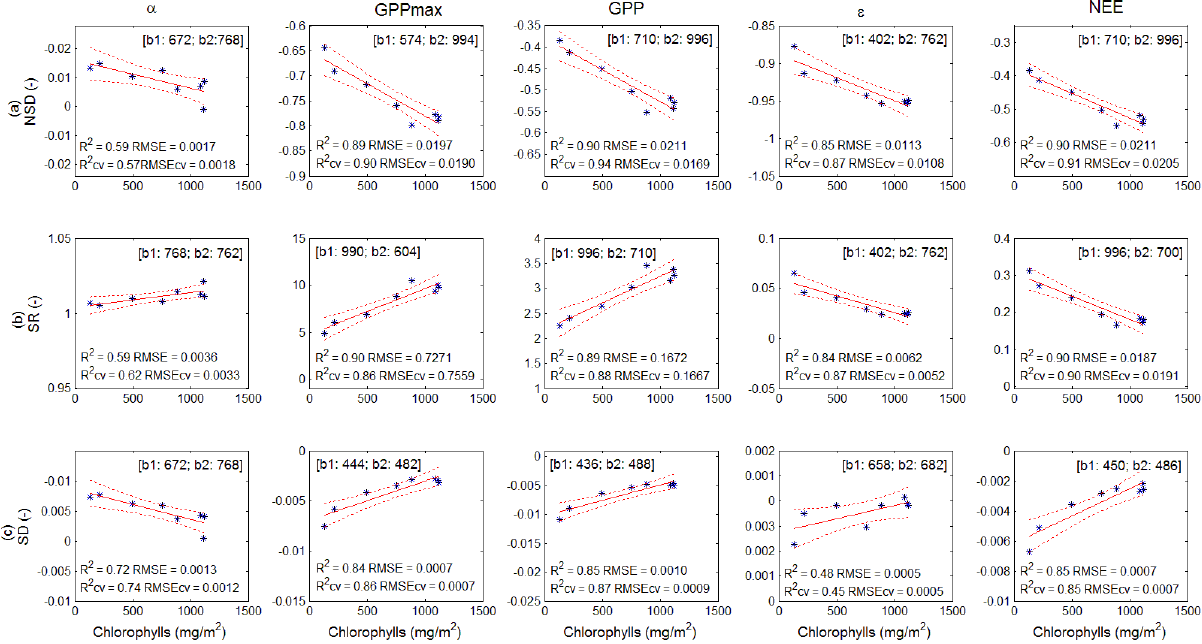
Figure 8. Correlation between selected (a) NSD-, (b) SR- and (c) SD-type indices for the α , GPP max , midday GPP, midday ε and midday NEE (plots in the columns) and the total chlorophyll content for Monte Bondone in 2013. R 2 – coefficient of correlation; RMSE – root mean square error; R 2 cv – cross-validated coefficient of correlation; RMSE cv – cross-validated root mean square error. The solid red lines indicate the fitted models, and the dotted red lines represent the 95% upper and lower confidence bounds. The selected bands for computing NSD-, SR- and SD-type indices are reported in